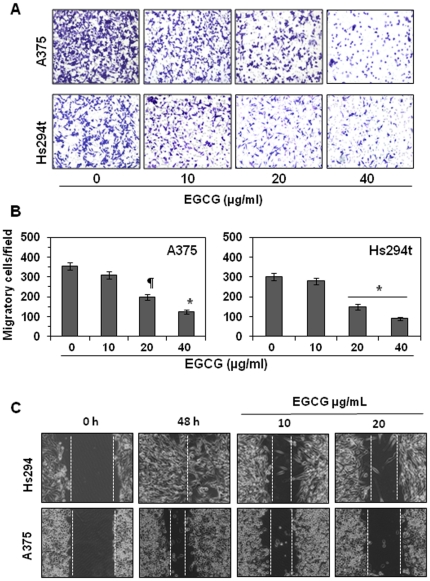
EGCG inhibits melanoma cell invasion/migration.(A) Treatment of human melanoma cells with EGCG for 24 h inhibits migration of A375 and Hs294t cells in a concentration-dependent manner. (B) The migrating cells were counted and the results expressed as the mean number of migratory cells ± SD/microscopic field. Significant inhibition by EGCG versus non-EGCG-treated controls, ¶
P<0.01; *
P<0.001. (C) Scratch or wound healing assay was performed to assess the effect of EGCG on the migration of A375 and Hs294t melanoma cells. Incubation of A375 or Hs294t cells with EGCG (10 and 20 µg/mL) for 48 h inhibits migration of cells compared to non-EGCG-treated control cells. Assay was repeated three times and representative pictures are shown. Space between dotted lines in each panel shows the space without or negligent number of migrating cells.